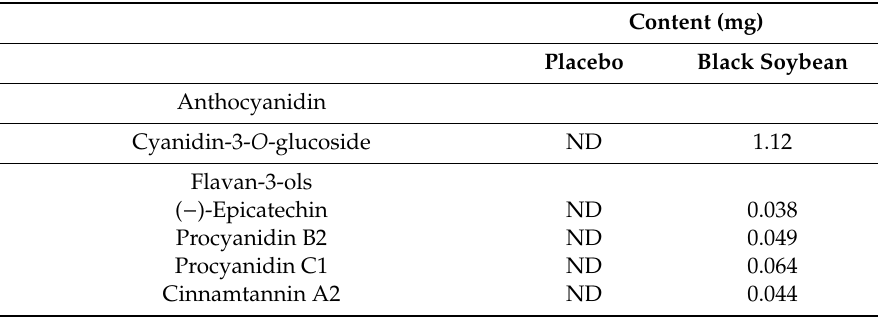
Table 2. Polyphenol contents in test